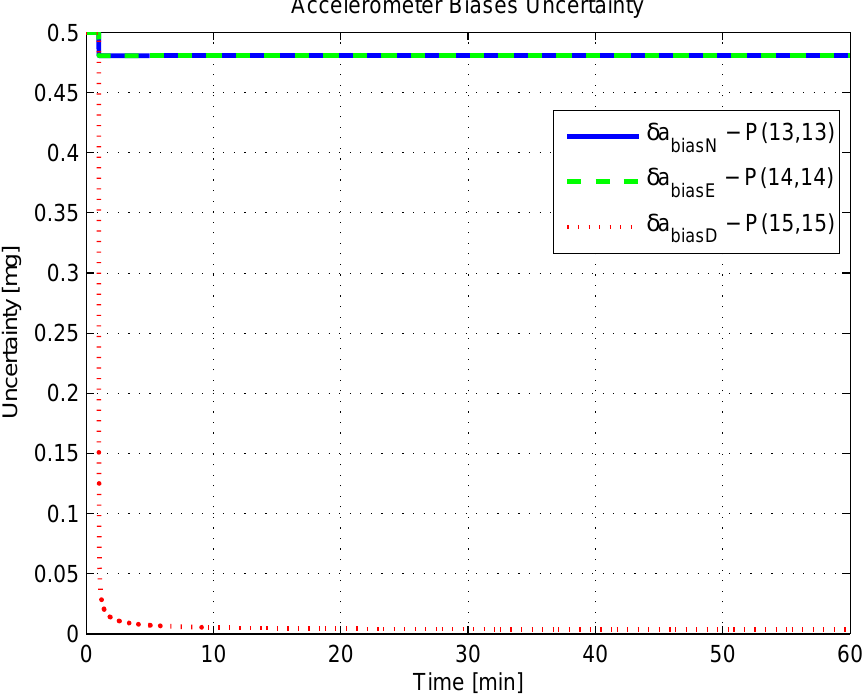
Figure 6. Accelerometer biases uncertainty in the simulated